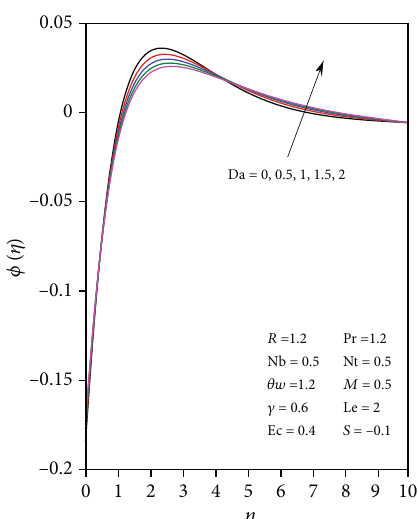
Figure 13: Concentration of nanoparticle pro fi le for di ff erent values of Da .